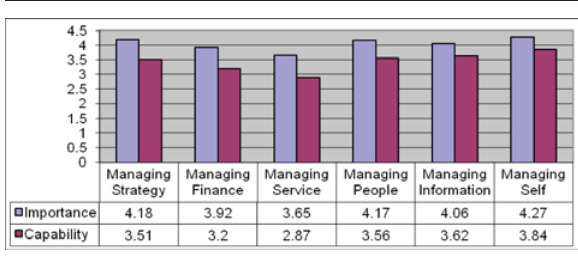
Figure 2. Difference between mean score for reported Importance andCapability for Nurses (n = 23)